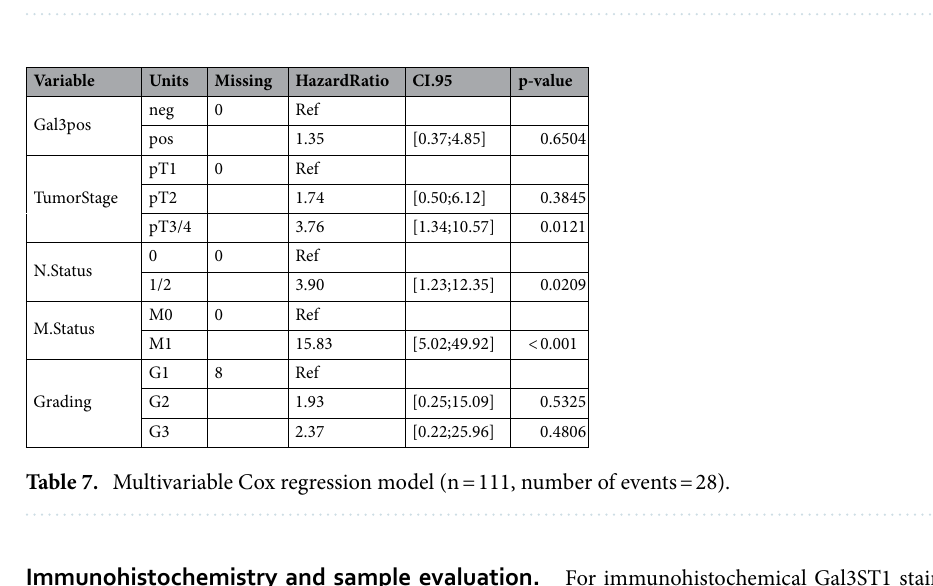
Table 6. Multivariable Cox regression model (n = 119, number of events = 29).